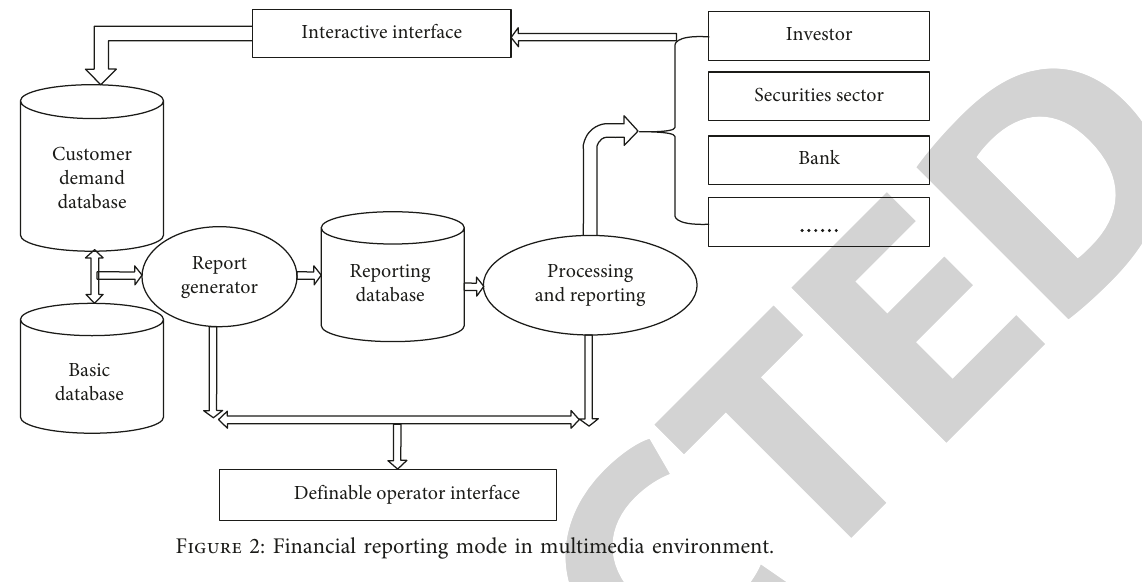
Figure 3: Basic database content.